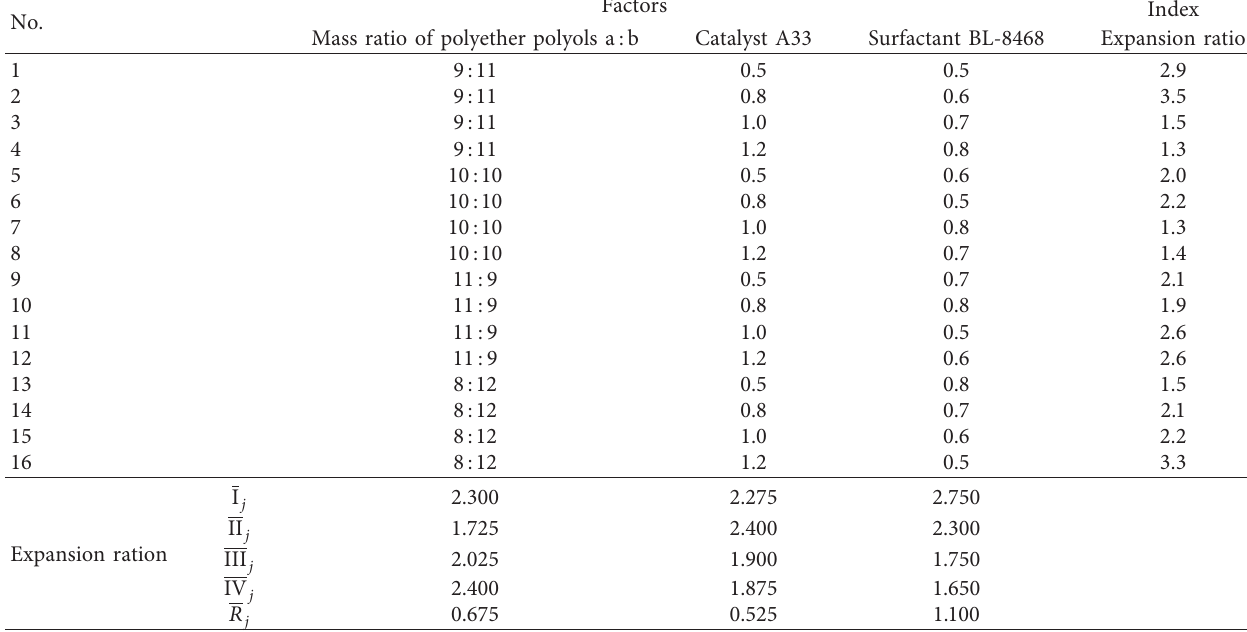
Table 5: Results of expansion ratio.